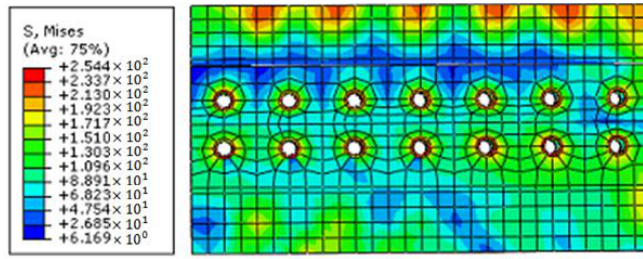
Figure 17. Stress cloud diagrams of the connector.